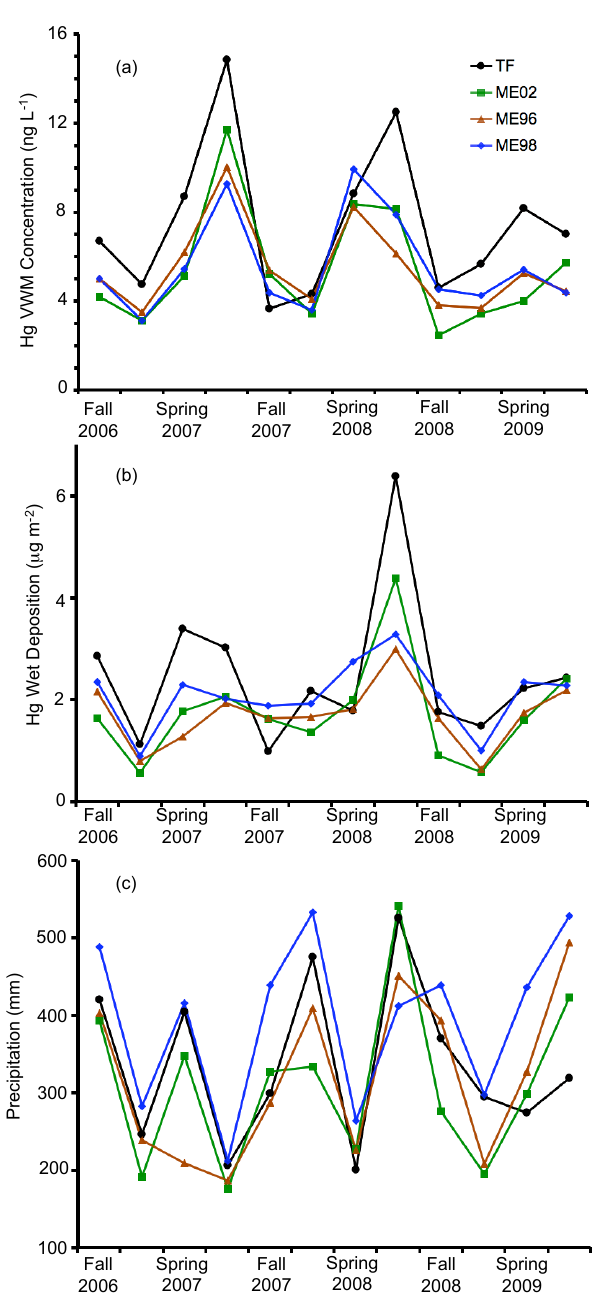
Fig. 3. Seasonal Hg volume weighted mean concentrations (a) , Hg wet deposition (b) , and precipitation amount (c) , at Thompson Farm and Mercury Deposition Network sites located in